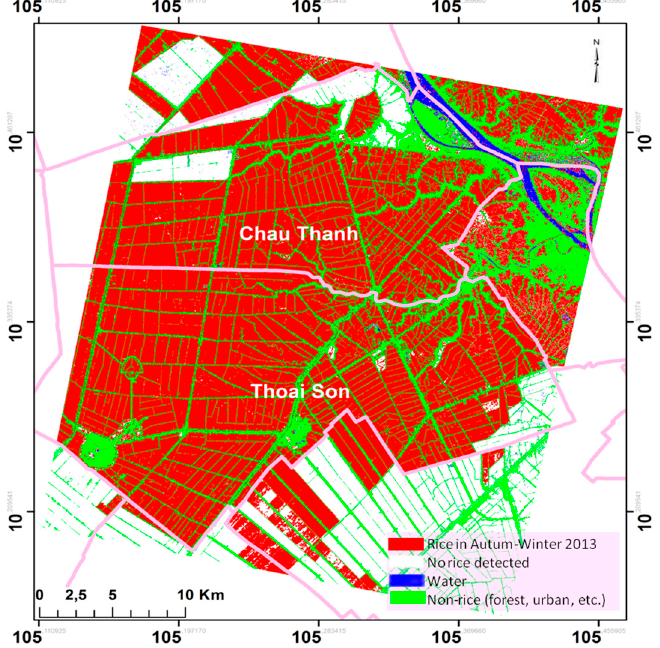
Figure 11. Rice and non-rice map of Autumn-Winter season in 2013. Red: Rice at Autumn-Winter; Blue: Water; Green: built areas and trees; White: no rice detected.